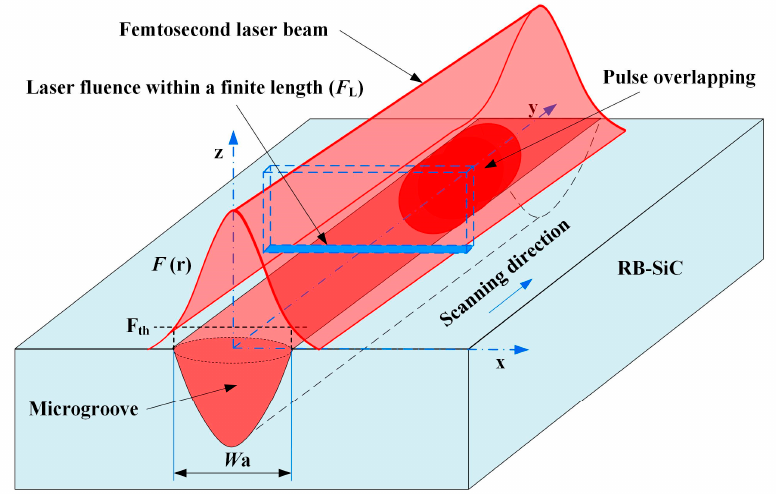
Figure 2. Schematic diagram of laser-ablated microgroove and the spatial distribution of laser fluence.